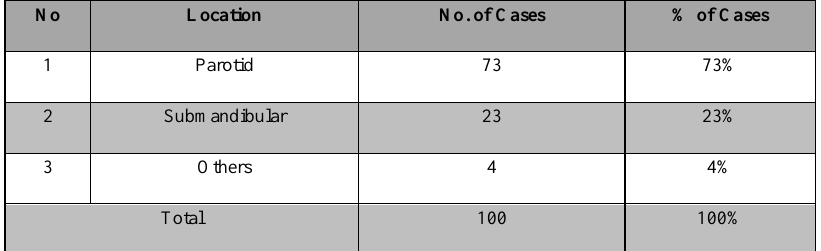
Table 2. Distribution of location-wise salivary gland